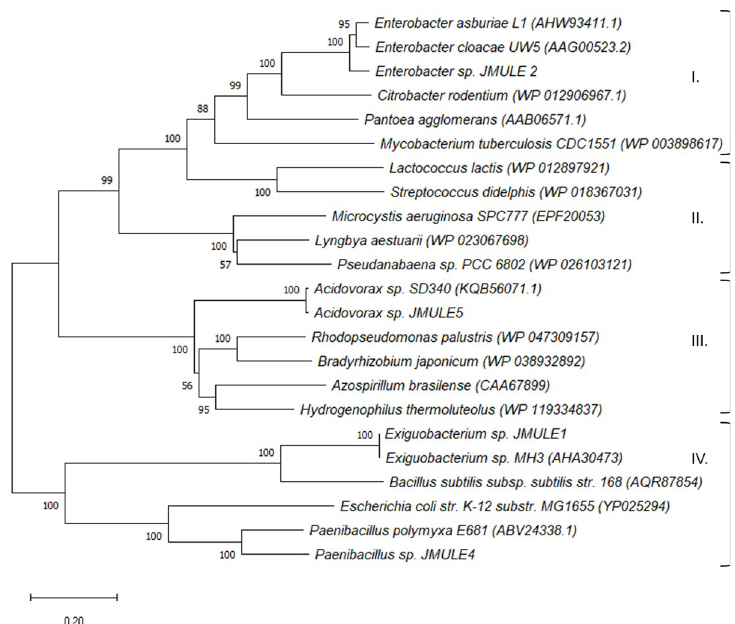
Fig 2. Phylogenetic tree of bacterial homologues of indolepyruvate decarboxylase (IpdC). Clusters are based on similarity to sequences of known function, specifically indolepyruvate decarboxylase (Group I), α -keto decarboxylase (Group II), acetolactate synthase (Group III), and phenylpyruvate decarboxylase (Group IV). Sequence alignment (527 amino acids) was performed using T-coffee (Notredame et al ., 2000; Di Tomasso et al ., 2011) and the Neighborhood- Joining phylogenetic tree was generated in Mega X (Kumar et al ., 2018) with a bootstrap test of phylogeny (1000).